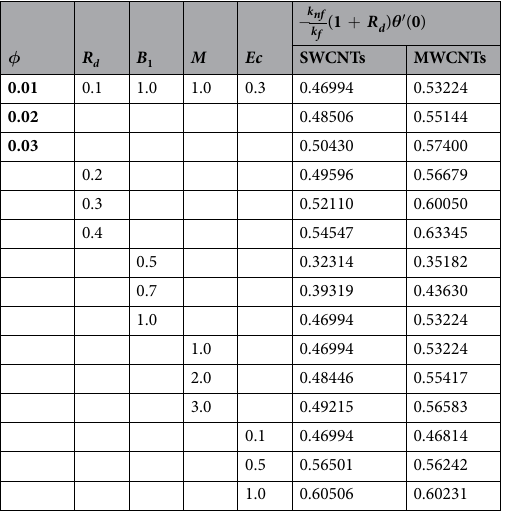
Table 4. Values of Nusselt number